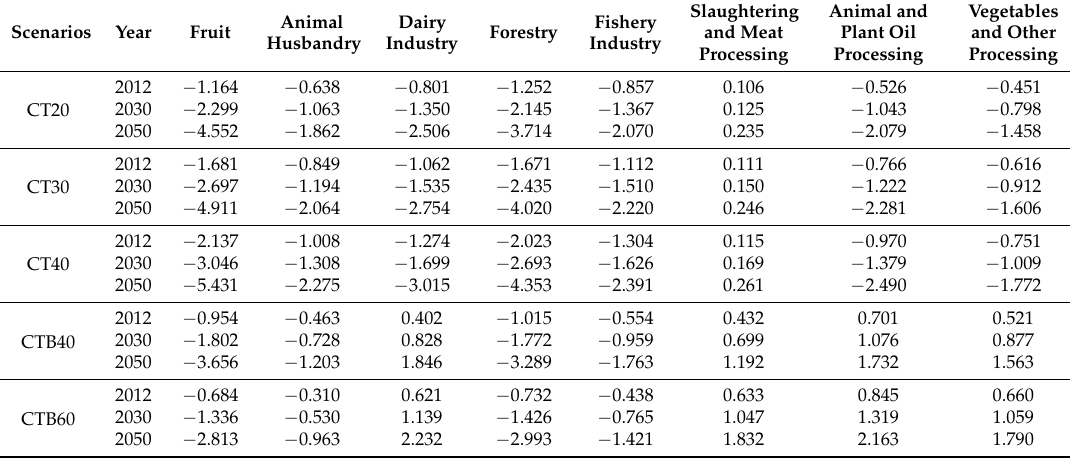
Table 6. The changes in the return on capital in agriculture-related sectors under different scenarios compared with the BAU scenario (%) (from fruit to vegetables and other processing).